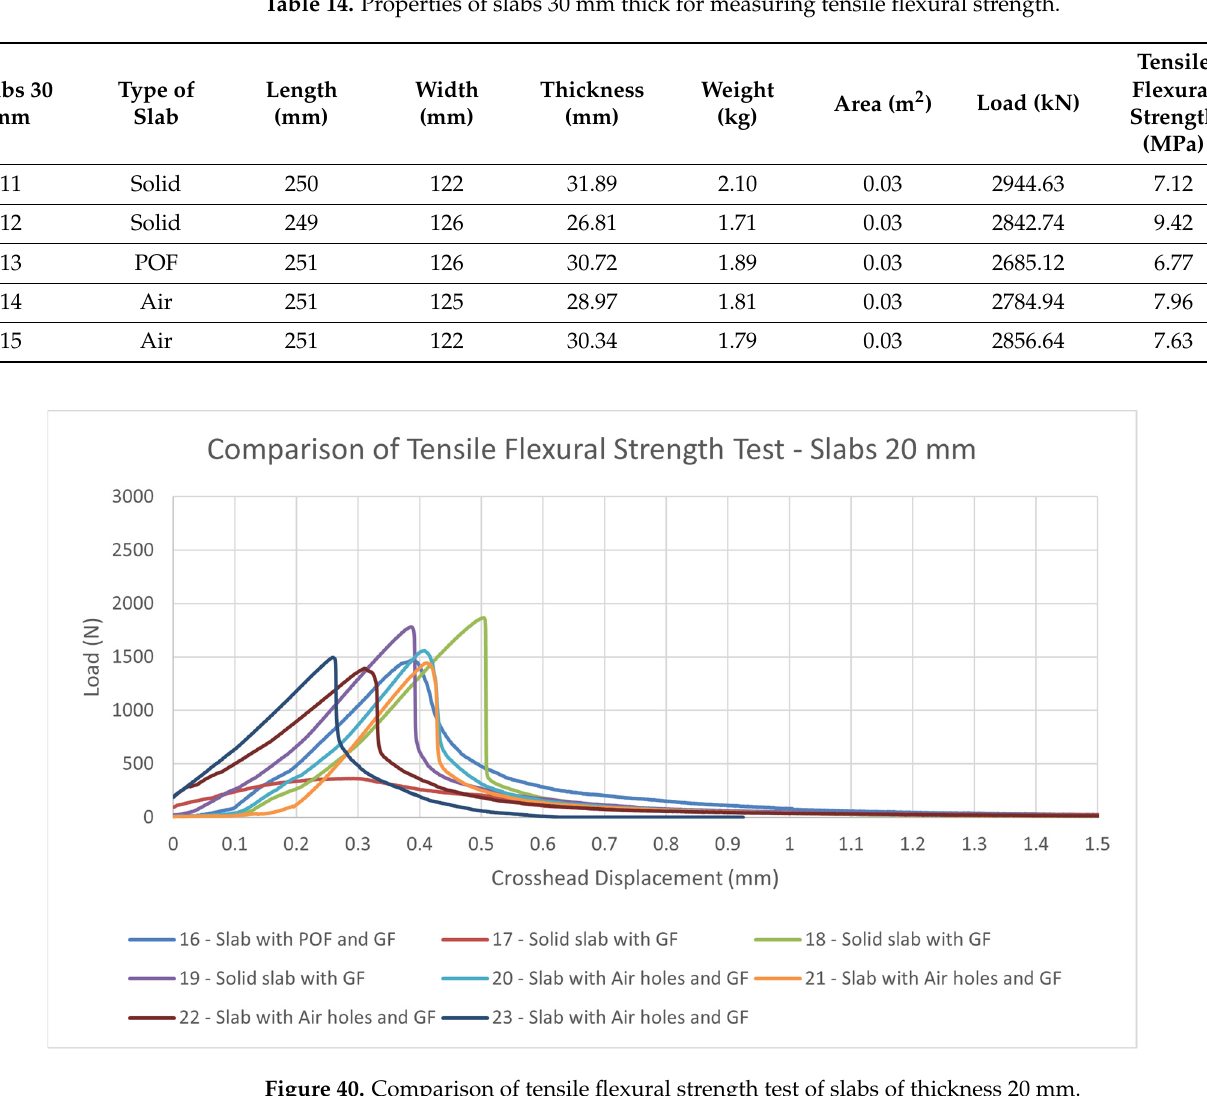
Table 14. Properties of slabs 30 mm thick for measuring tensile flexural strength.